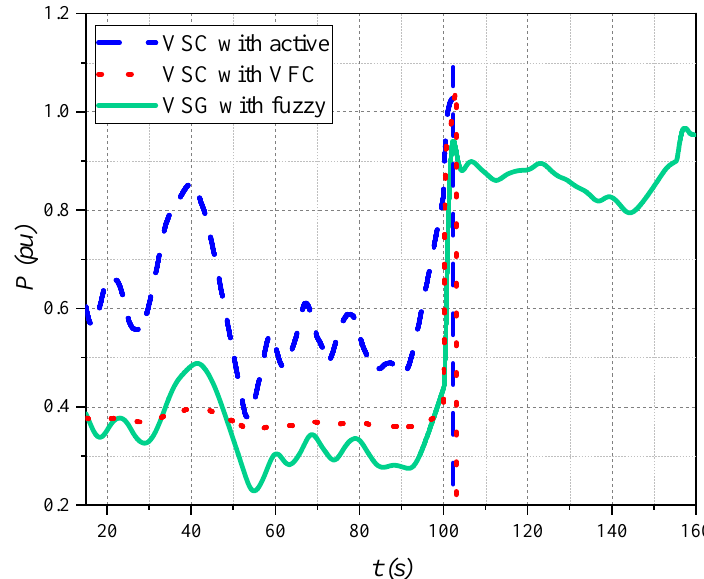
Figure 23. DER 1 output active power for various scenarios.